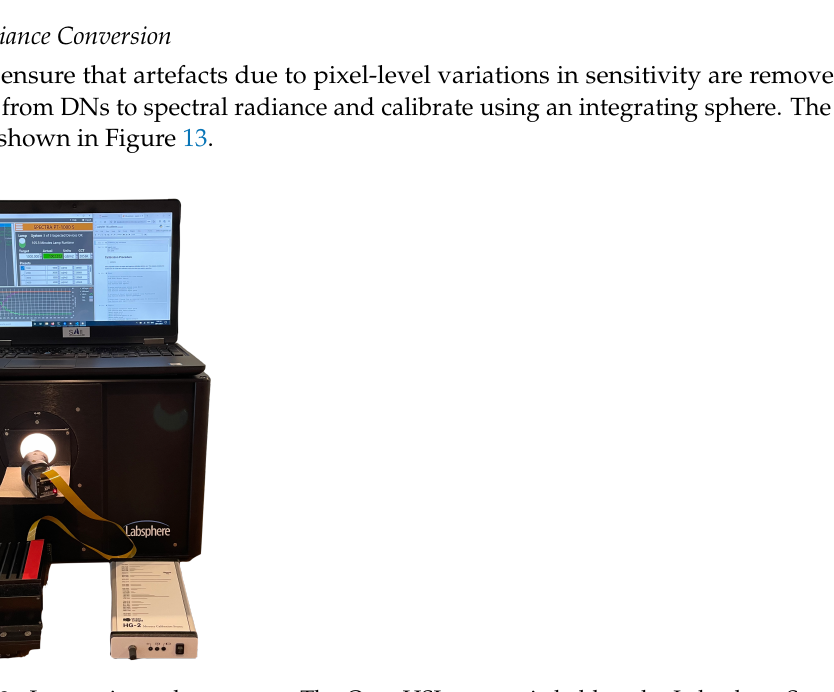
Figure 13. Integrating sphere setup. The OpenHSI camera is held at the Labsphere Spectra-PT integrating sphere exit port on a fixed